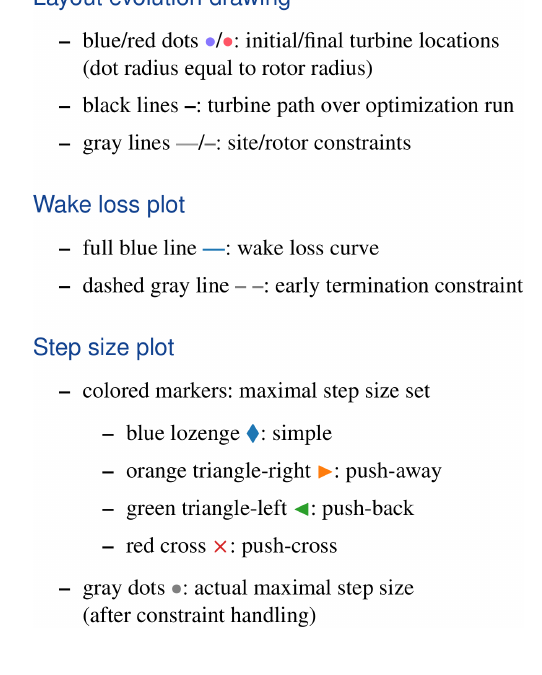
Table 1. Legend for optimization run overview